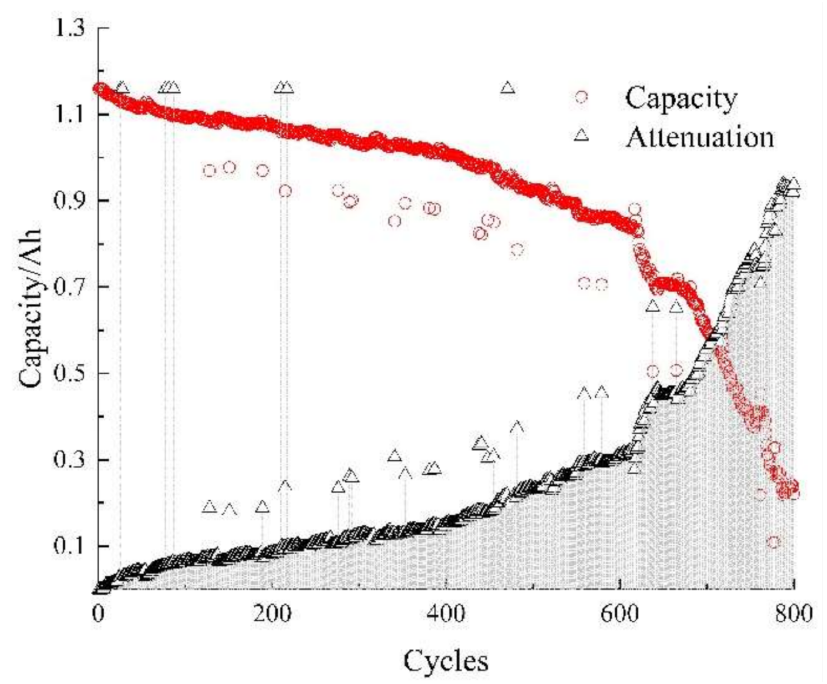
Figure 5. CS2#35 capacity and attenuation